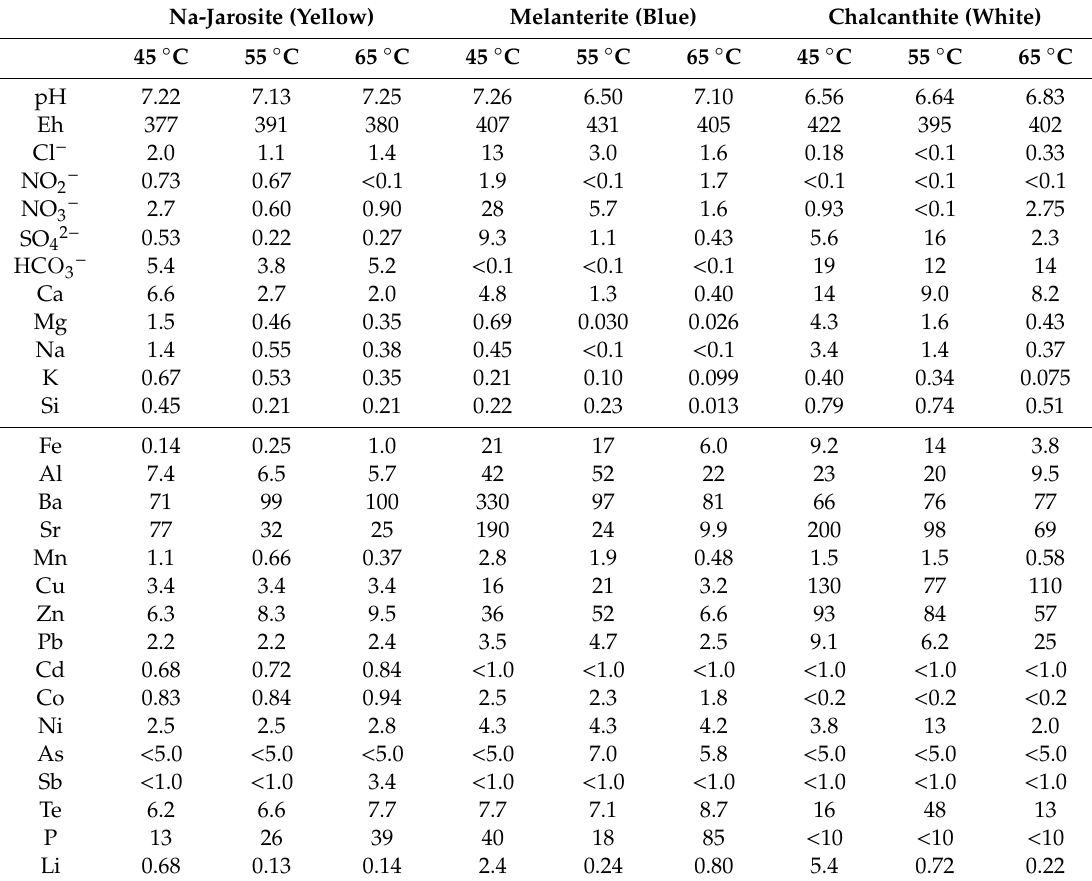
Table 2. The composition of gas condensates after the e ffl orescence samples heating, Cl − –Si in mg / L, Fe–Li in µ g /